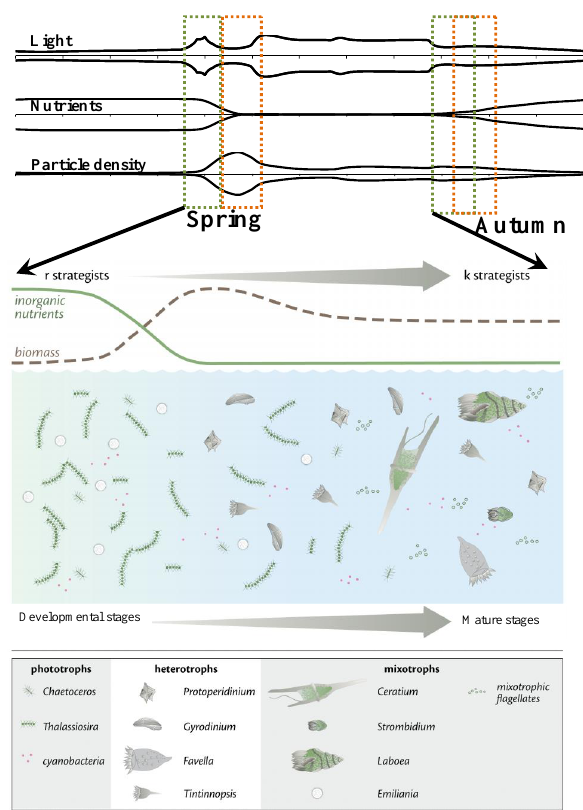
Fig. 1. Diagrammatic portrayal of the changes to the planktonic food web over a year, with transitions between ecosystem states. The upper panels show changing patterns of light, inorganic nutri- ents and particle density (i.e. total plankton biomass) over the tem- perate year. Transitions between developmental and mature stages of the ecosystem are as indicated; green and orange dashed lines indicate the developmental stages, where green represents condi- tions optimal for phototrophy and orange for phagotrophy. Later periods (transition to the more mature state) are suboptimal for strict phototrophs and/or strict phagotrophs, and more supportive for mixotrophs. The lower panel shows in detail the transition from developmental to mature stages, with changes in selection priori- ties from “r-selected” phototrophs and phagotrophs in the devel- opmental phase of the ecosystem to a mature ecosystem with “K- selected” mixotrophs. For definitions and discussion of develop- mental vs. mature state, and r vs. K selection, see Odum (1969) and Parry